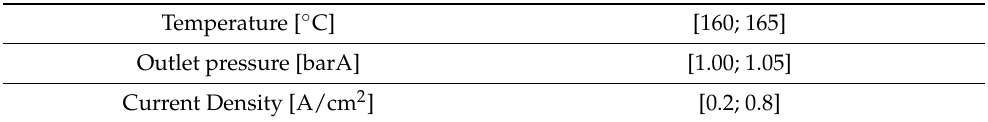
Table 3. The different operating conditions explored during the reduced pressure and temperature design of